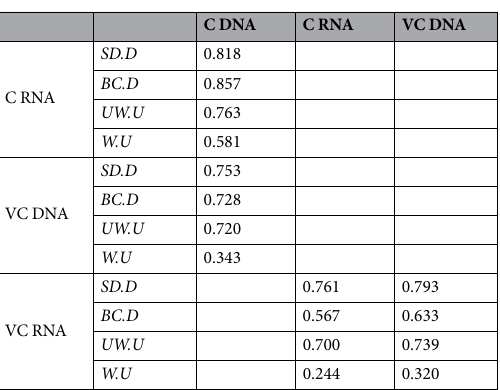
C DNA C RNA VC DNA